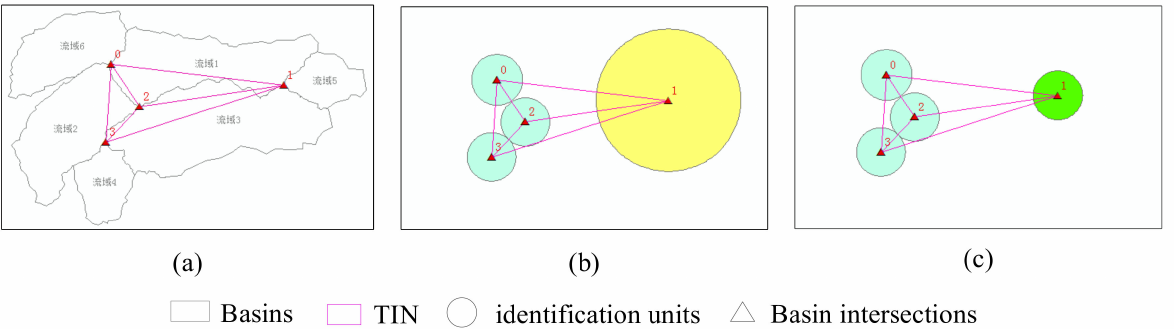
Figure 7. The process of identification unit extraction. ( a ) Constructing TINs based on basin intersec- tions. ( b ) Calculating radii and generating the circular buffers. ( c ) Optimizing the buffers whose radii are